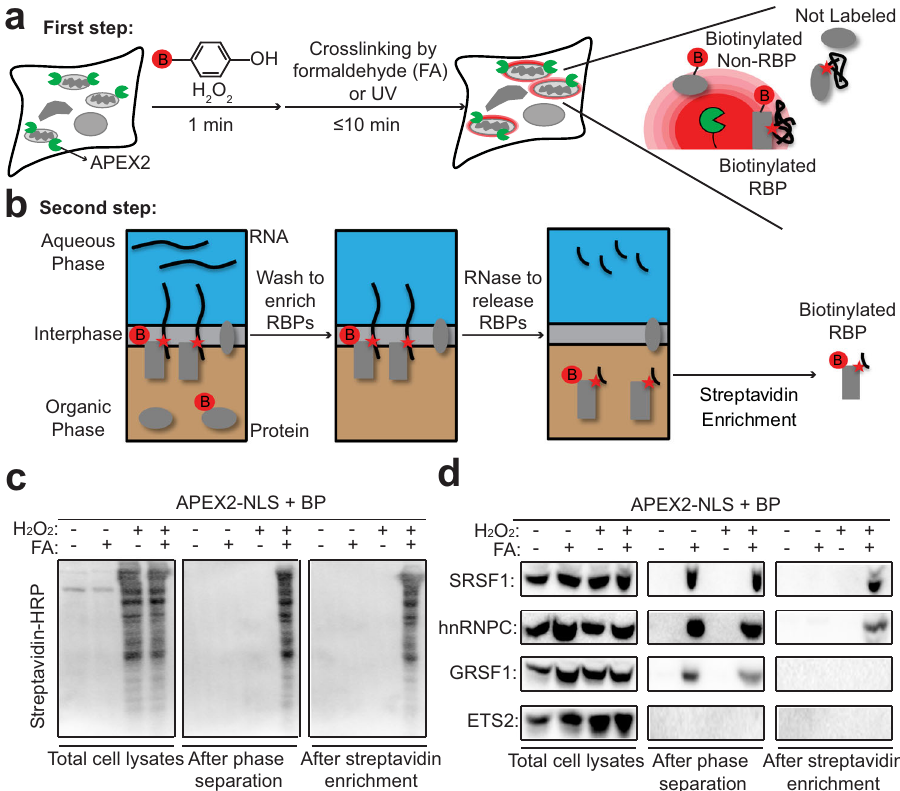
Fig. 2 Development and validation of APEX-Phase Separation (APEX-PS) for enrichment of subcellular RNA-binding proteins (RBPs). a In the fi rst step of APEX-PS, 1 min APEX-catalyzed biotinylation is carried out, followed by 10 min of RNA – protein crosslinking in living cells. Red B, biotin. RBP, RNA- binding protein. b In the second step of APEX-PS, phase separation of cell lysate from a localizes crosslinked protein – RNA complexes to the interphase, while free proteins and RNA localize to the organic and aqueous phases, respectively. After washing, RNA-crosslinked proteins are released from the interphase by RNase treatment and subjected to streptavidin bead-based enrichment of biotinylated proteins. c Streptavidin blotting reveals enrichment of nuclear RBPs by APEX-PS. Biotinylation and formaldehyde crosslinking were performed in HEK293T cells expressing nuclear-localized APEX (APEX-NLS). Streptavidin blotting was performed on total cell lysate (left), samples after phase separation (middle), and samples after both phase separation and streptavidin enrichment (right). d Western blot detection of known nuclear RBPs in samples from c . SRSF1 and hnRNPC are true-positive nuclear RBPs, GRSF1 is a mitochondrial RBP, and ETS2 is a nuclear protein that does not bind RNA organic layer and RNAs partition to the aqueous layer, while crosslinked RNA – protein complexes partition to the interphase (Fig. 2b). After washing, RBPs can then be speci fi cally released to the organic layer by RNase digestion, and extracted from this layer. OOPS has been used to identify mammalian RBPs on a large scale, albeit with loss of spatial information 26 .